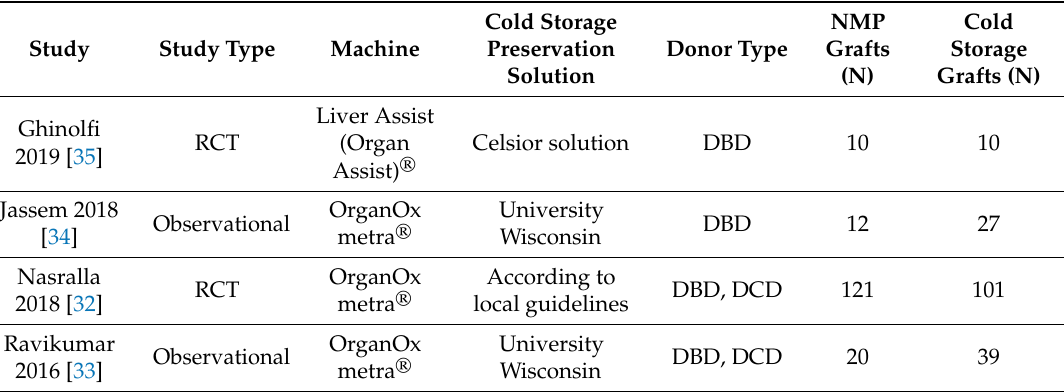
Table 4. Studies comparing NMP and SCS in